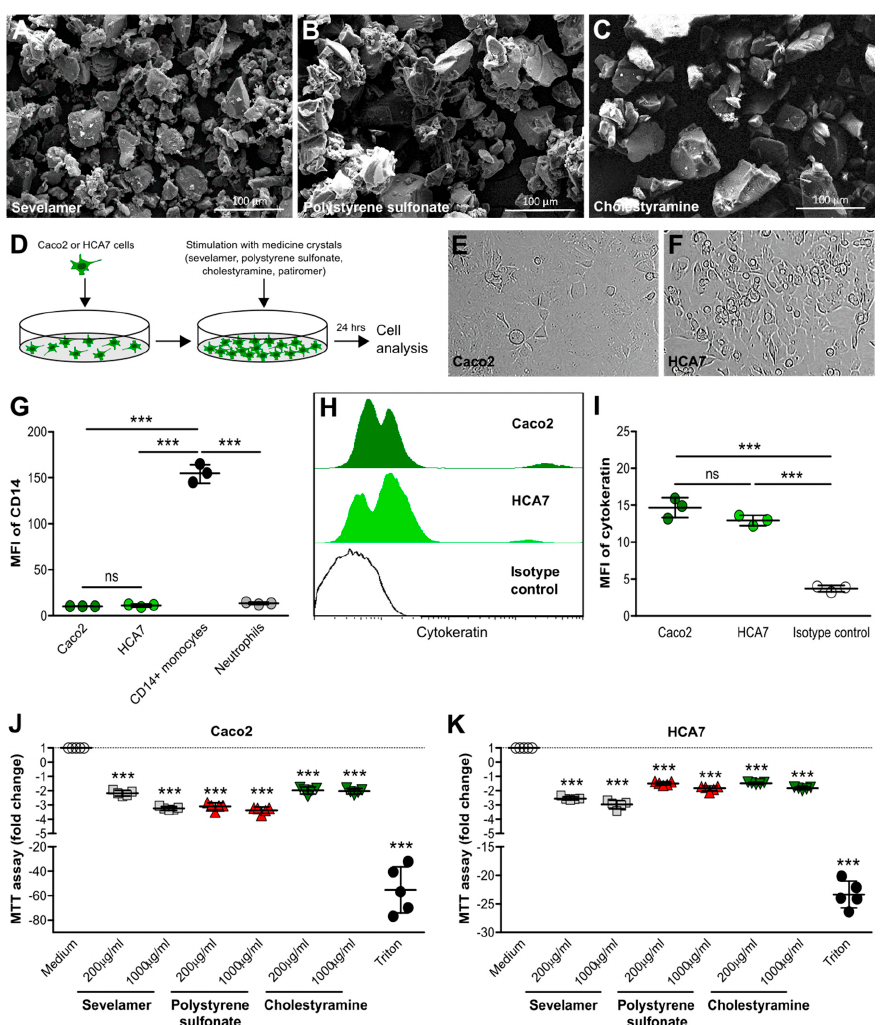
Figure 2. Crystals of ion-exchange resins reduce metabolic activity in intestinal epithelial cells. ( A – C ) Scanning electron microscopy illustrates sevelamer ( A ), polystyrene sulfonate ( B ), and cholestyramine ( C ) crystals of different sizes and shapes. ( D ) Schematic of in vitro culture set-up of human Caco2 and HCA7 intestinal epithelial cell lines. ( E , F ) Light microscopy of human Caco2 ( E ) and HCA7 ( F ) intestinal epithelial cell lines (400× magnification). ( G ) Caco2 and HCA7 cells, as well as human blood neutrophils and CD14+ monocytes, were stained for the surface marker CD14 and analyzed by flow cytometry ( n = 3). ( H , I ) Caco2 and HCA7 cells with cytokeratin or isotype control (using CaCo2 cells) and flow cytometry performed. Histogram ( H ) and the mean fluorescence intensity (MFI) ( I ) are shown ( n = 3). ( J , K ) Human Caco2 and HCA7 intestinal epithelial cell lines were stimulated with different concentrations of sevelamer, polystyrene sulfonate, and cholestyramine crystals (200 or 1000 µg/mL) for 24 h. Triton served as a positive control. After stimulation, culture supernatants were collected and 3-(4,5-dimethylthiazol-2-yl)-2,5-diphenyltetrazolium bromide (MTT) assays were performed. The fold change is shown ( n = 5). Data are means ± SD. * p ≤ 0.05; ** p ≤ 0.01; *** p ≤ 0.001; ns, not significant ( p > 0.05) versus the medium using one-way ANOVA.